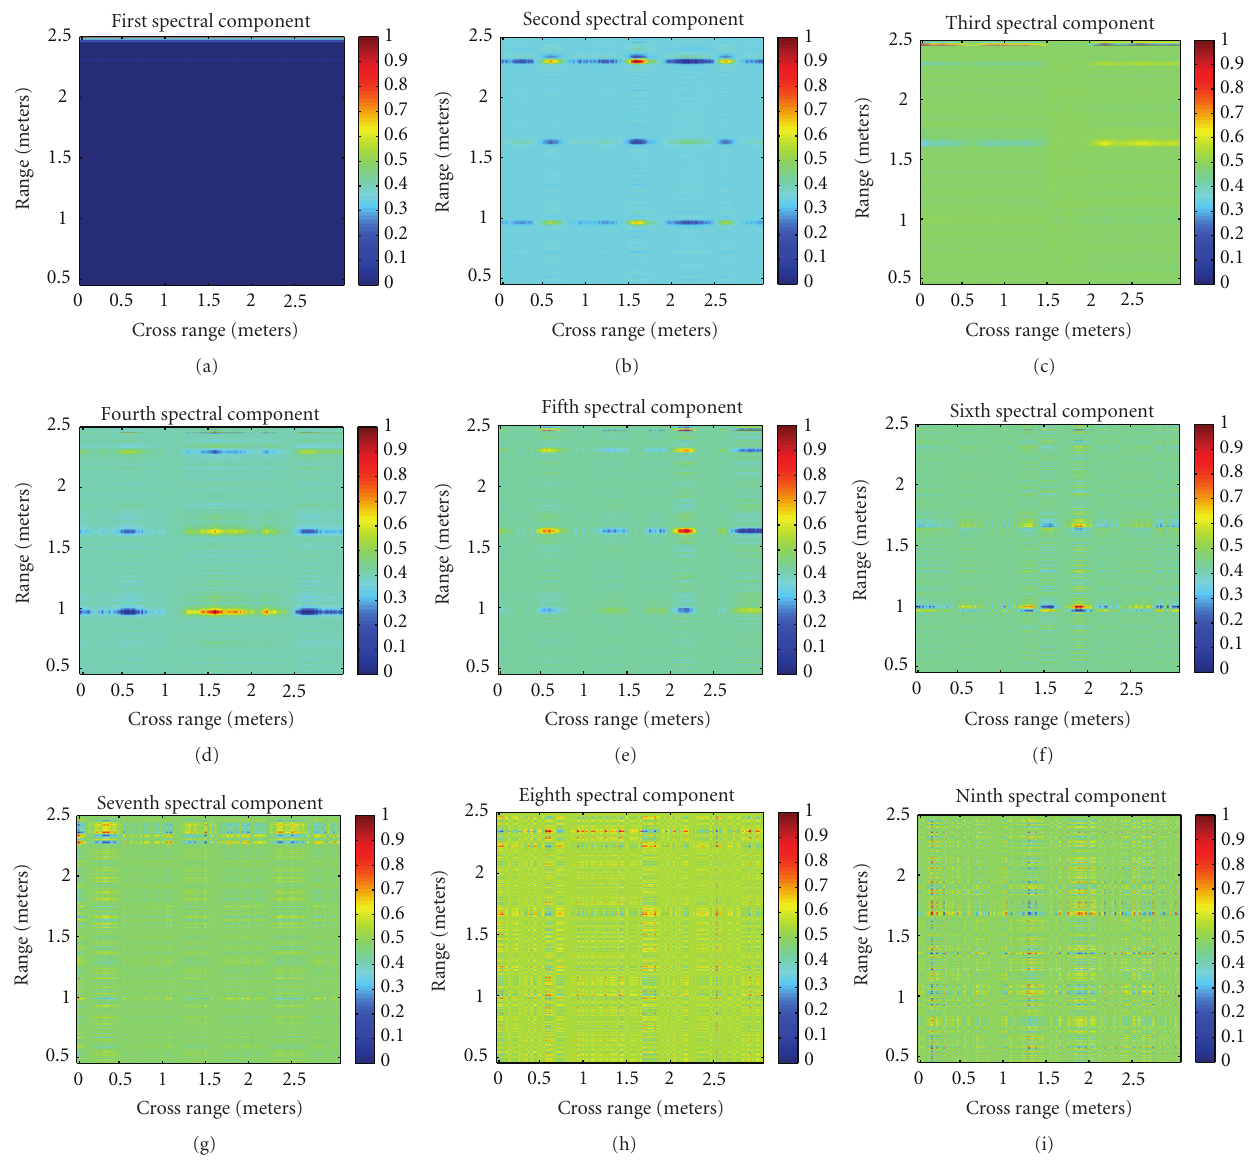
Figure 17: Example 4: Multiple (five) targets: di ff erent spectral